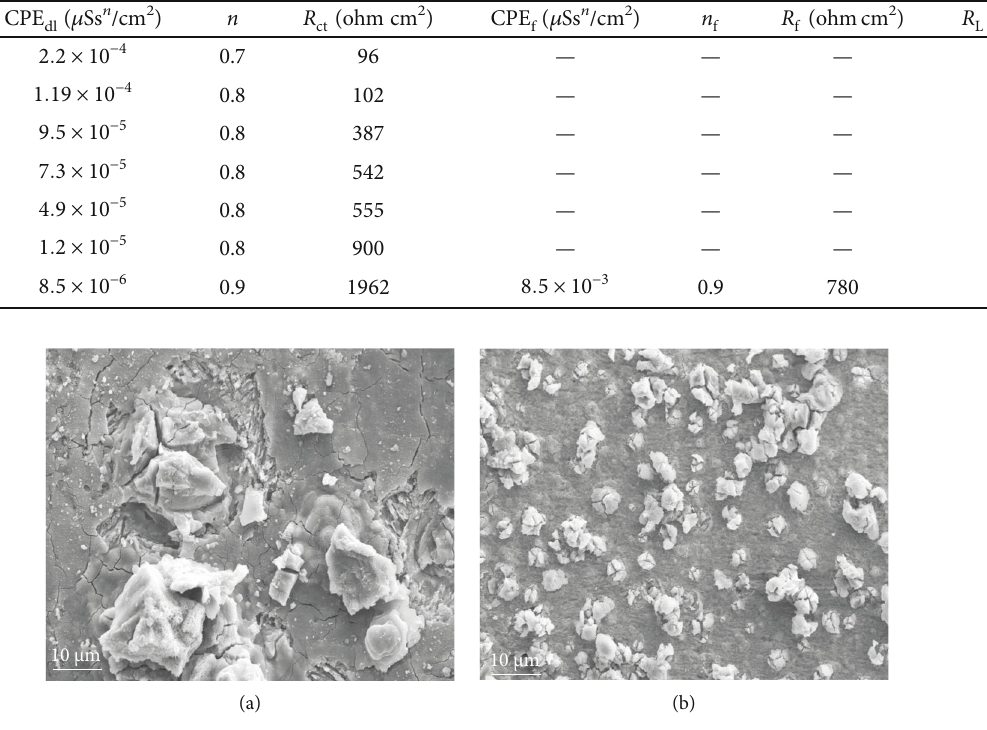
Figure 9: SEM micrographs of corroded 1018 carbon steel in 0.5M H complex.